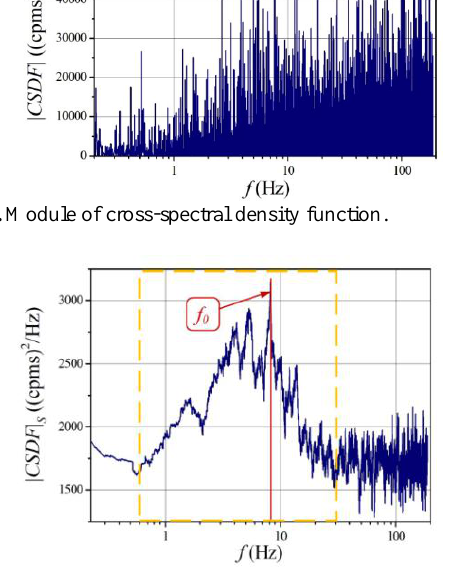
Fig. 5. Smoothed module of cross-spectral density function |CSDF| S .